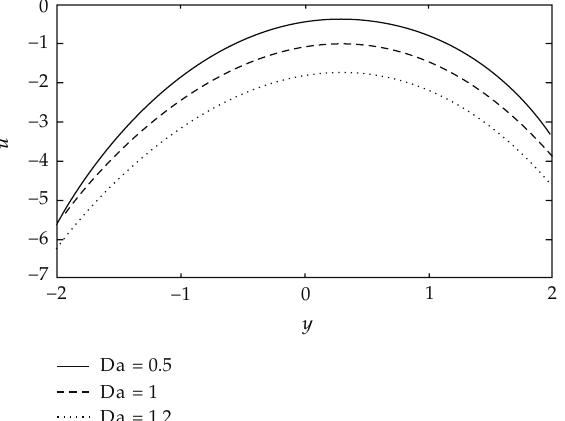
Figure 11: Axial velocity versus y at α (cid:9) 0 . 05, a (cid:9) 0 . 2, b (cid:9) 0 . 6, d (cid:9) 0 . 8, ε (cid:9) 0 . 2, λ 1 (cid:9) 1, q (cid:9) − 1, x (cid:9) π/ 6, and φ (cid:9) π/